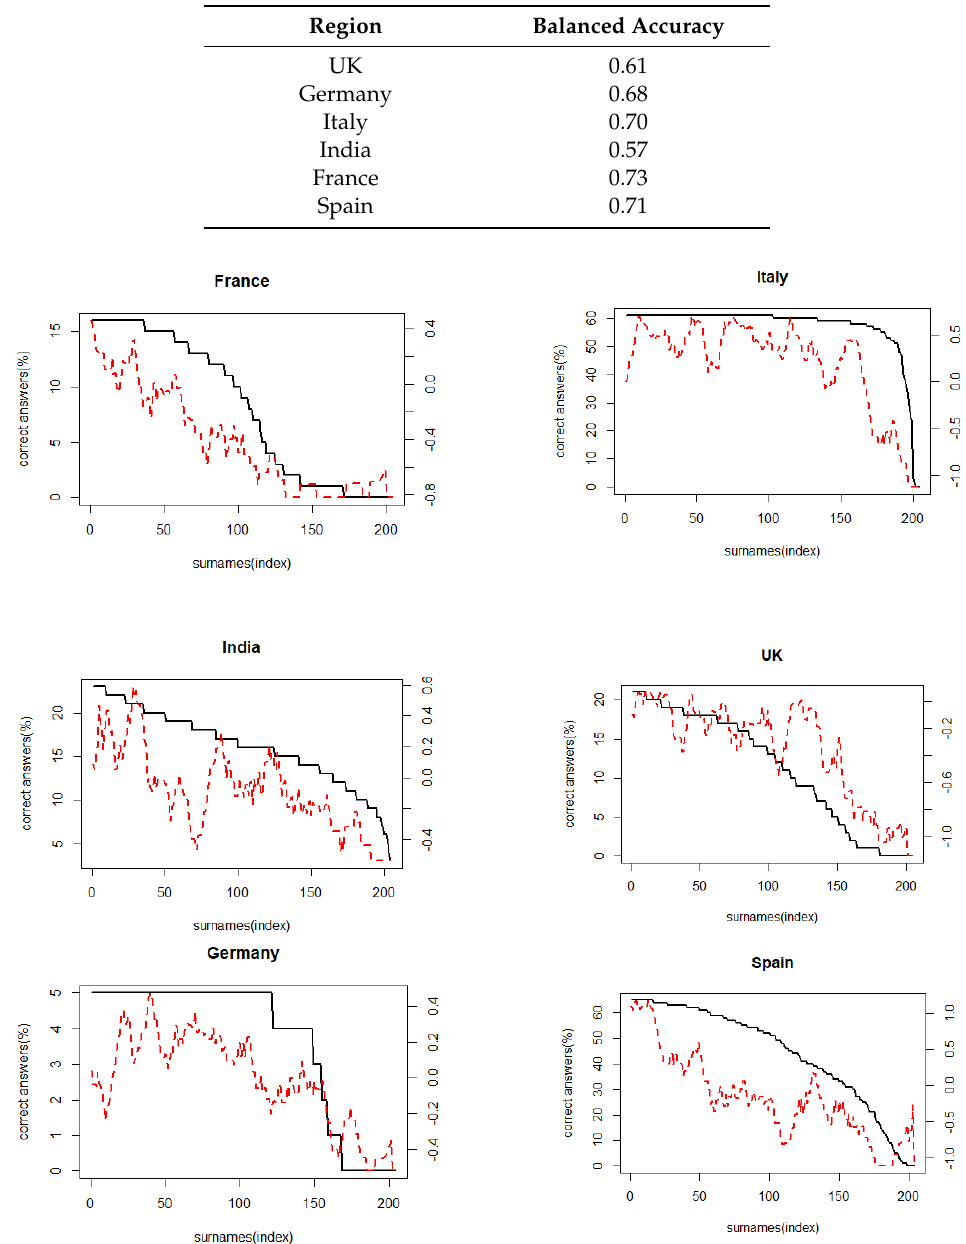
Figure 4. Relation between human and classifier results. (x-axis) index of surnames; black line represents the rate of correct answers by humans (y-axis of the left), the red line represents predicted difficulty of the classifier (y-axis of right).